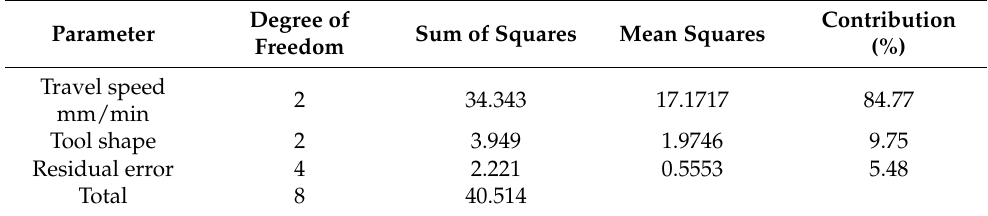
Table 9. ANOVA for